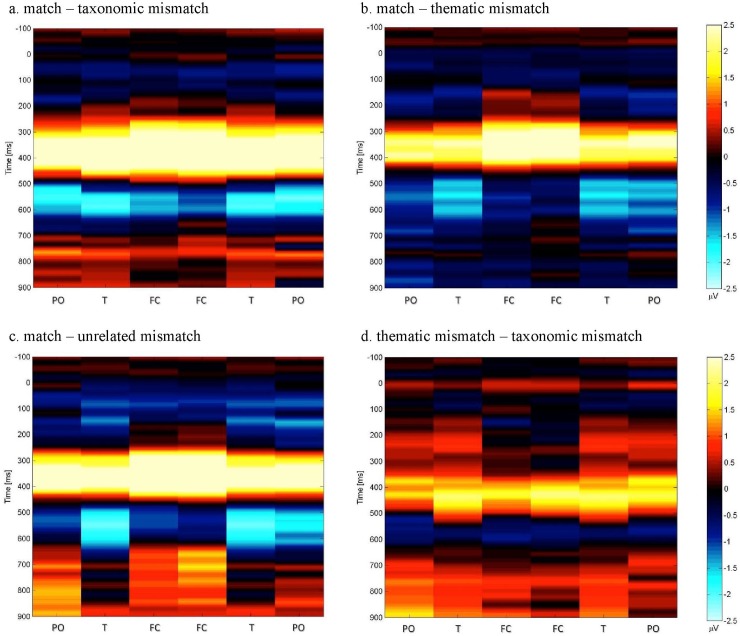
Dynamic maps showing the difference in ERP waves for match type conditions.(a) match–taxonomic mismatch (top left), (b) match–thematic mismatch (top right), (c) match–unrelated mismatch (bottom left), (d) thematic mismatch–taxonomic mismatch (bottom right). Time in milliseconds is shown on the vertical axis, starting in the baseline period 100 milliseconds prior to the onset of the critical stimuli. Labels on the horizontal axis stand for the six zones-of-grouping: P/0: parieto-occipital, T/PC: temporal, F/C: fronto-central. The color codes the value of the difference in the amplitudes of the waves. The scale on the left describes the difference in the amplitude of two waves in microvolts (μV).